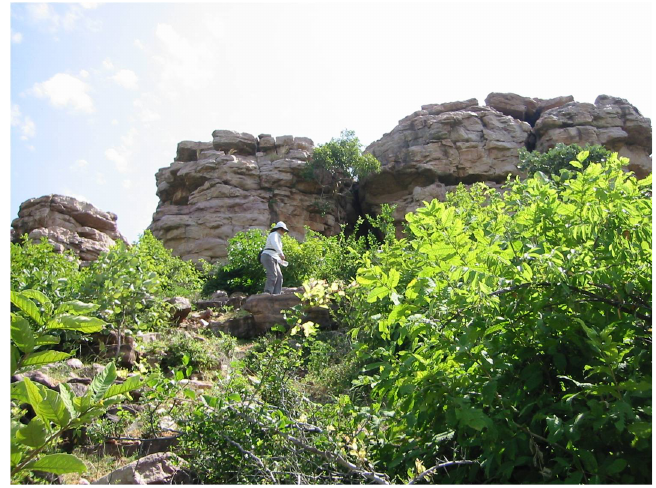
Figure 1. Daraki-Chattan Cave (DC) in the quartzite buttresses of Indragarh